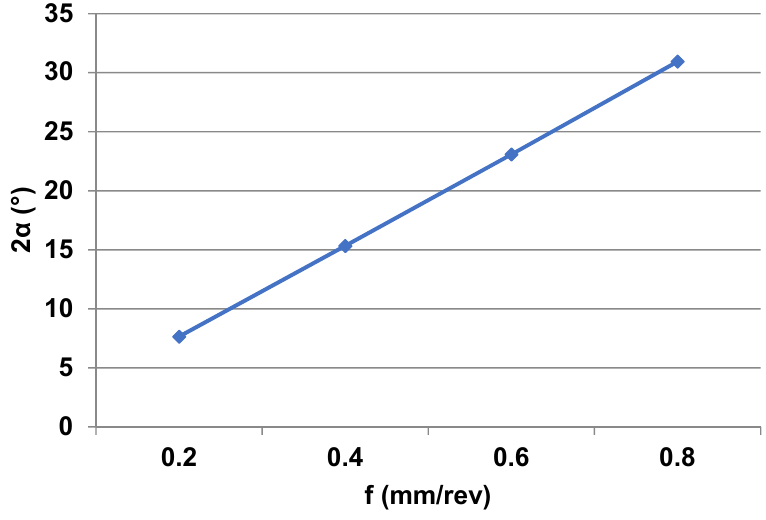
Figure 16. Effect of feed on the 2 α angle for r ε = 1.5 mm.